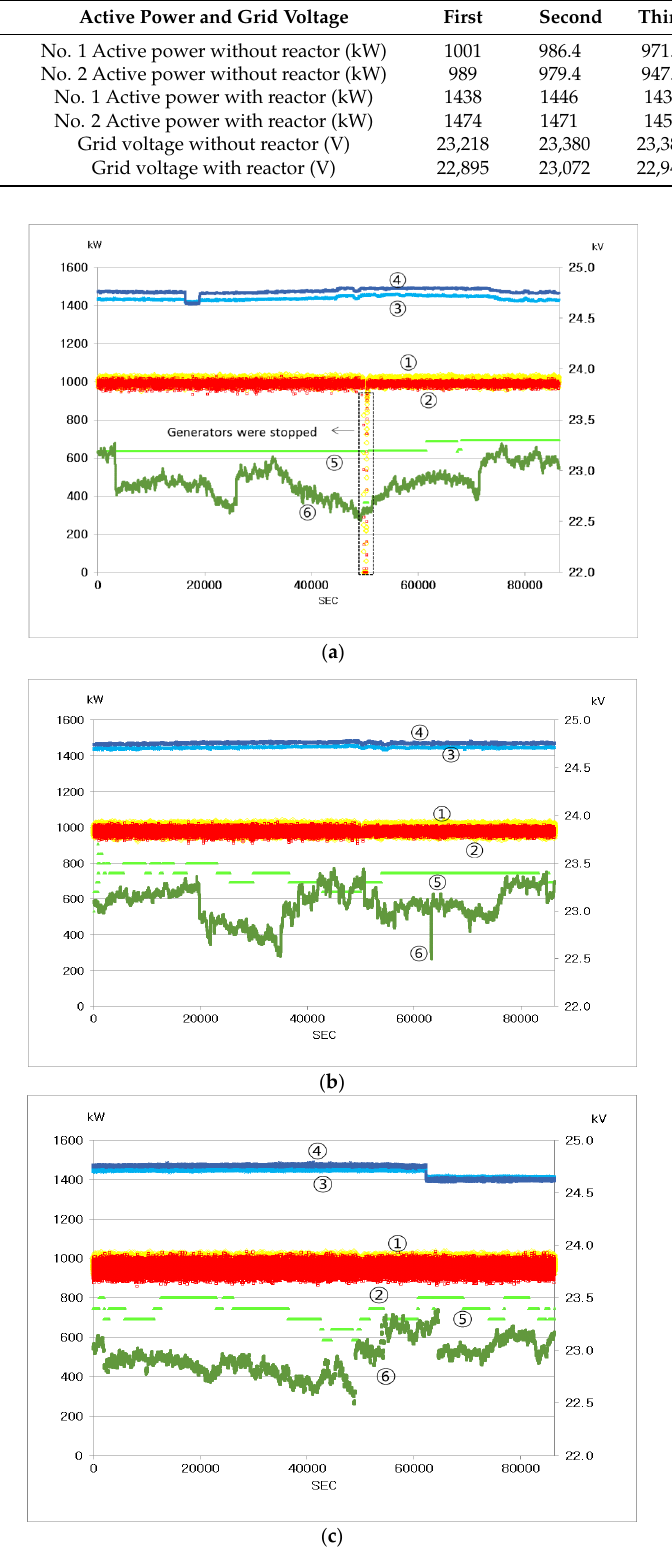
Figure 12. Output active power and daily grid voltage before and after installing reactors; locations ② , ③ , ④ , ⑤ , ⑥ are same as in Table 5 ( a ) first ( b ) second ( c ) third.